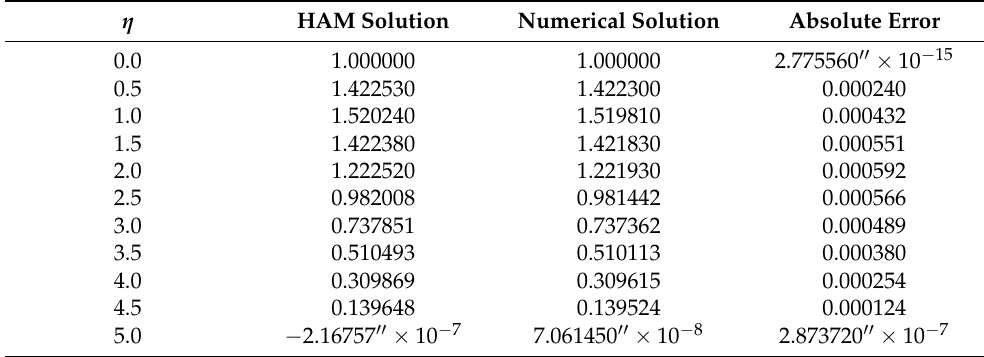
Table 3. Comparison table for HAM solution and numerical method for temperature field and their results.